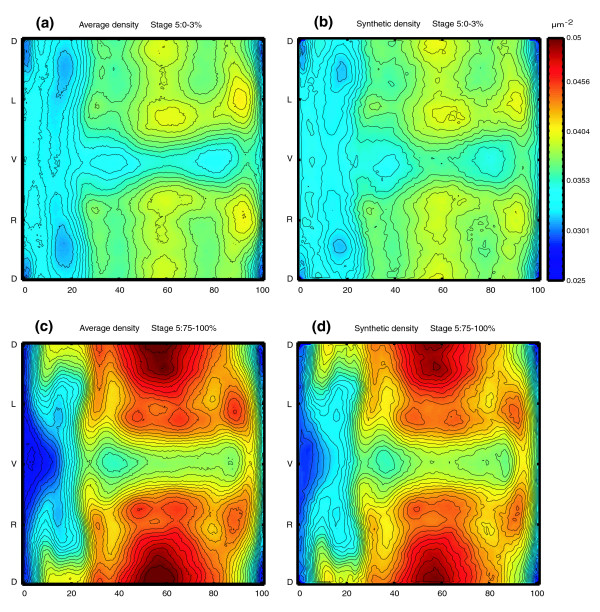
Synthetic density maps are similar to measured density maps. Cylindrical projections of nuclear density patterns in PointClouds from: (a) fixed early embryos (stage 5:0-3%); (b) an early synthetic embryo modeled to have shapes and nuclear density patterns of stage 5:0-3% fixed embryos; (c) fixed late embryos (stage 5:75-100%); and (d) a late synthetic embryo modeled to have shapes and density patterns of stage 5:75-100% fixed embryos according to the model described in the text. All other information and scales are as used in Figure 1.